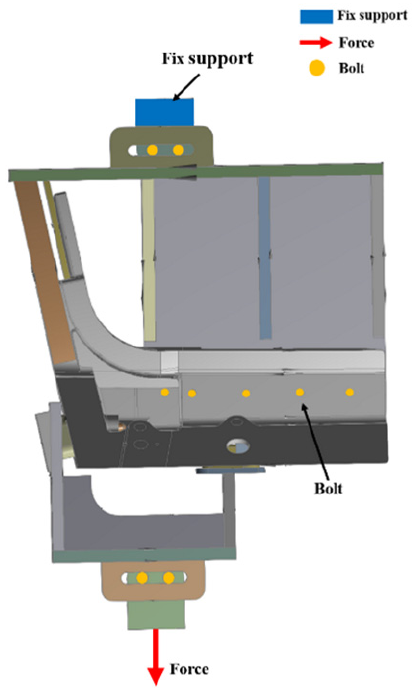
Figure 5. The boundary conditions of the numerical model.